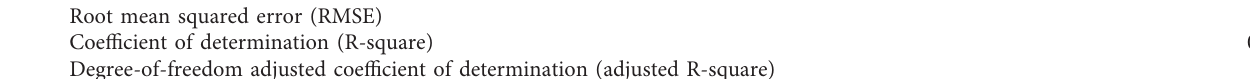
Table 2: Goodness of fit.